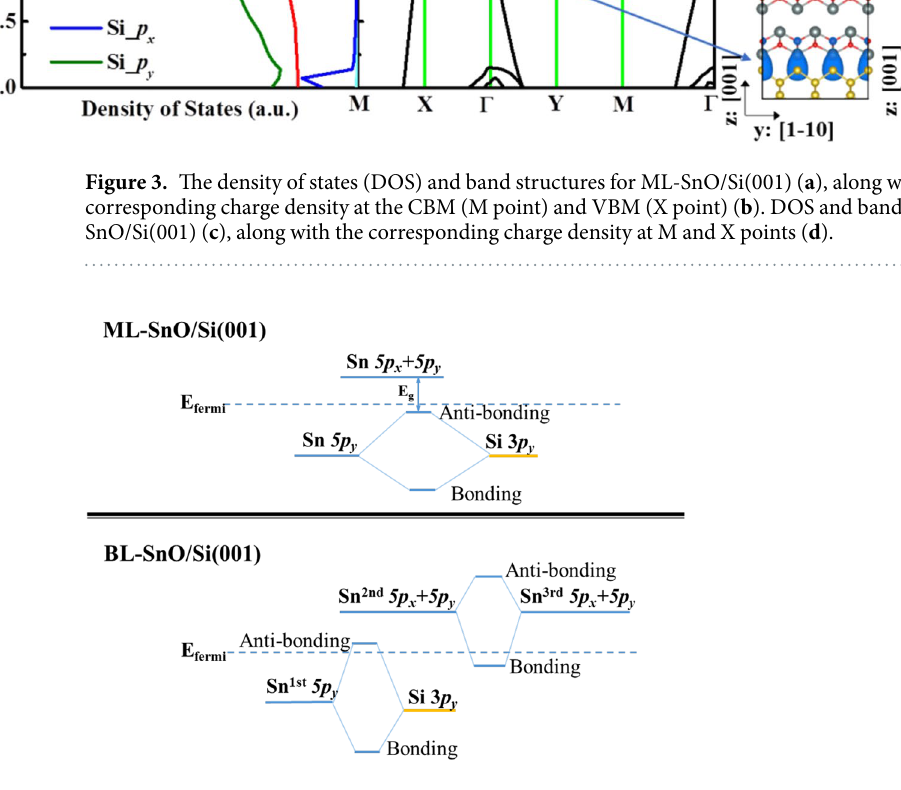
Figure 4. Energy-level evolution diagram around Fermi level associated with the ML-SnO/Si(001) (upper panel) and BL-SnO/Si(001) (lower panel).